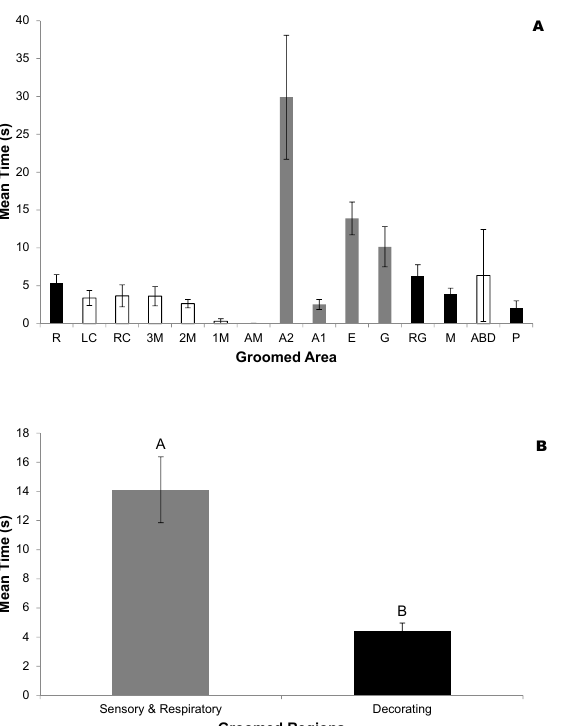
Figure 7. Mean frequency and time (s), with standard error bars, of individuals behaviors in 30-min agonistic observations (N=45). A. Mean frequency of behaviors (H=82.6, df=4, p<0.001). B. Mean time budget spent performing behaviors (H=75.6, df=4, p<0.001). Note: Similar letters indicate no statistical significance (p>0.05) and different letters indicate a statistical significance